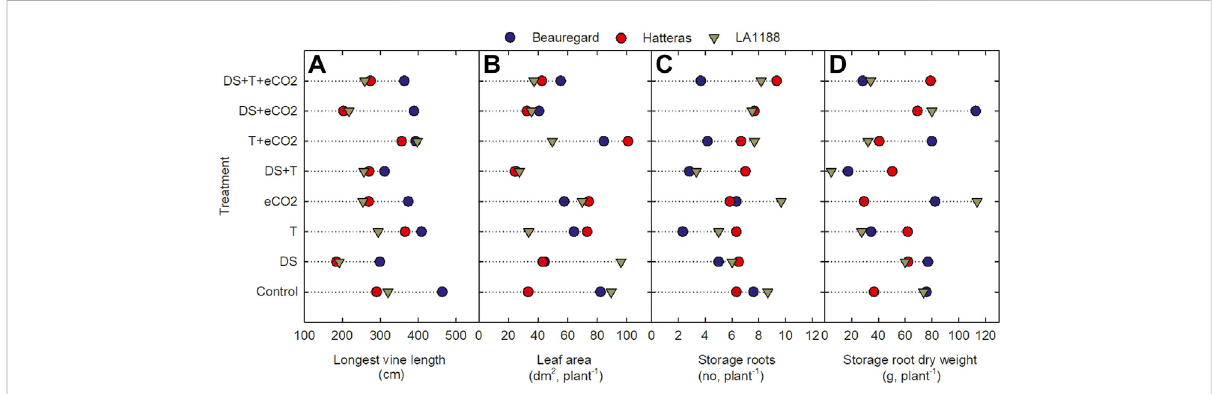
FIGURE 2 Effects of temperature (T), carbon dioxide concentration ([CO 2 ]), drought (DS), and their interaction on (A) vine length (B) leaf area, (C) storage roots, and (D) storage root dry weight for three sweetpotato cultivars (Beauregard, Hatteras, and LA1188). Each data point indicates the mean ± standard